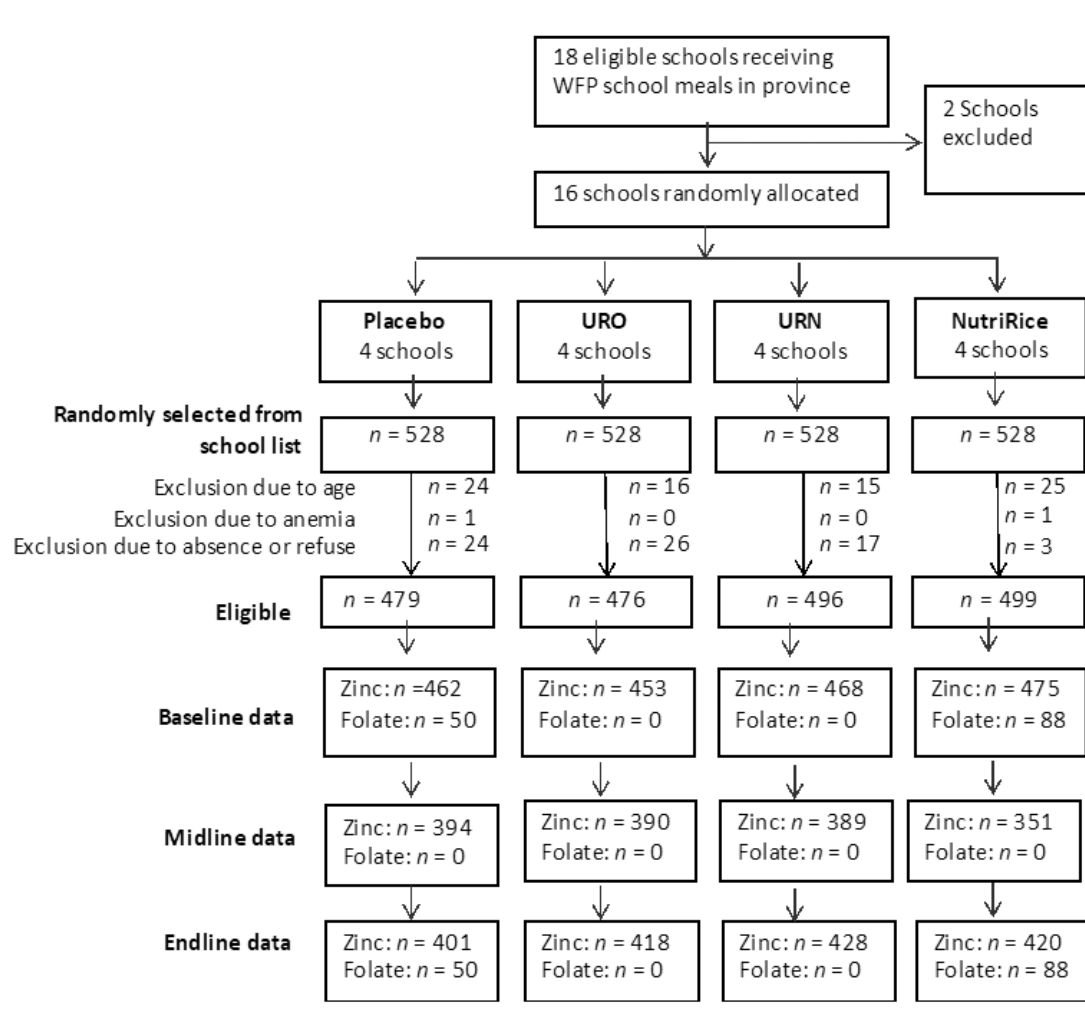
Figure 1. Flow chart of the study. Table 2. Baseline characteristics of children in the